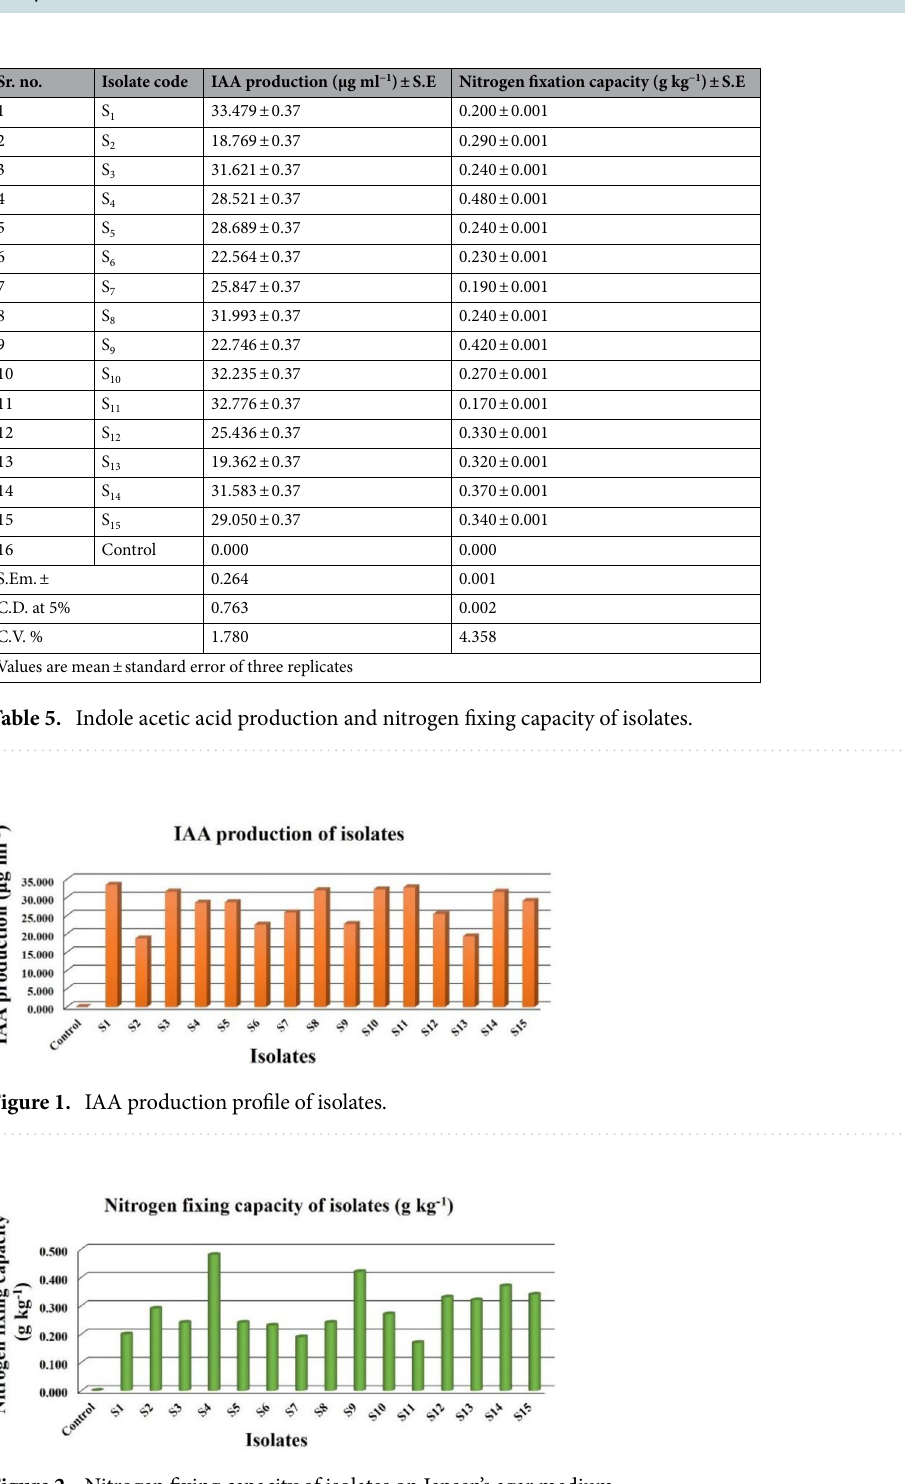
Figure 2. Nitrogen fixing capacity of isolates on Jensen’s agar